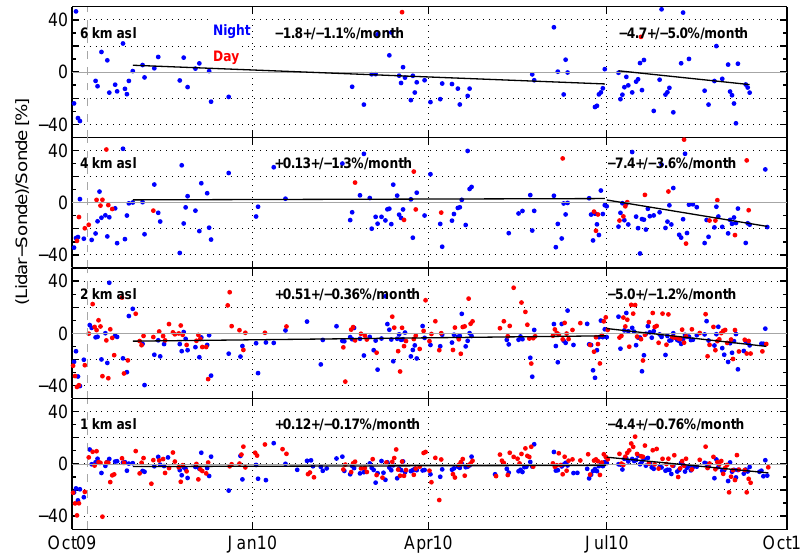
Fig. 3. Temporal evolution of water vapor mixing ratio differences between lidar and sonde at different altitude levels (from top to bottom: 6, 4, 2 and 1 km a.s.l.). Trends are shown for two time periods: from November 2009 to June 2010, the system remained relatively stable, and from July to September 2010, a drift is visible. The drift is mainly due to a photodetector sensitivity decrease. A recalibration was performed beginning of October 2009.